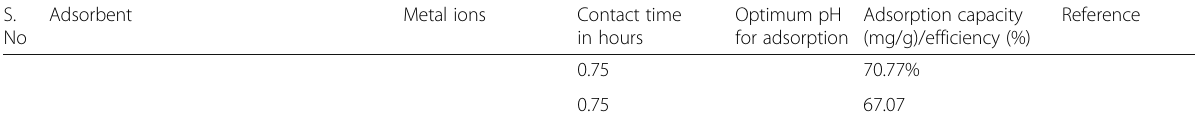
Table 2 Effect of different parameters on the process of metal ion adsorption (Continued) S. Adsorbent Metal No